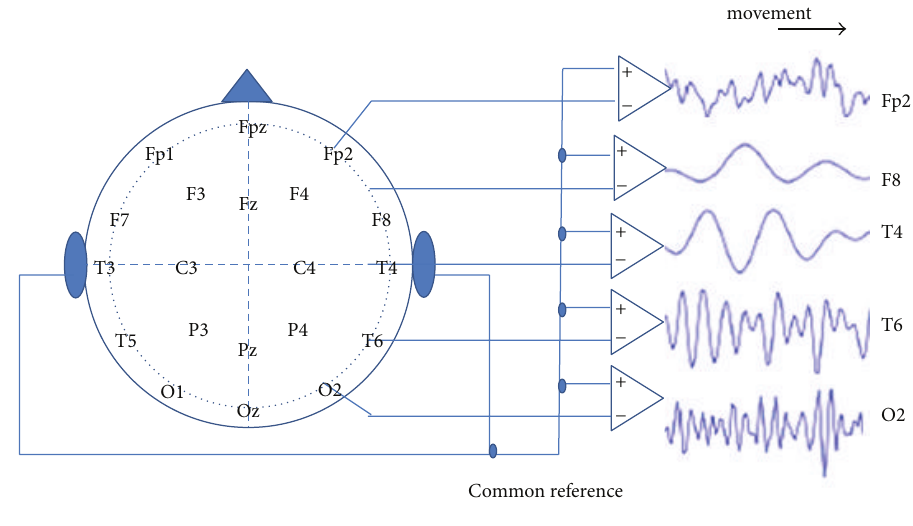
Figure 6: EEG referential montage.